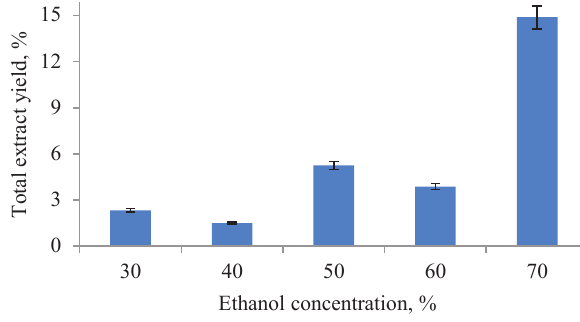
Figure 4 Solvents efficiency in extracting biologically active substances from ginseng root